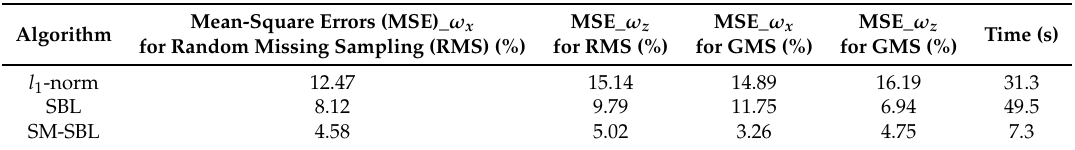
Table 3. Numerical comparison of algorithm performance.